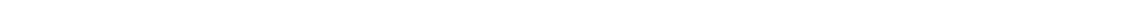
Fig. 1 Selective killing effects of a131 in cancer cells. a Structure of a131. b Normal and transformed BJ cells were treated with a131, paclitaxel or nocodazole at a range of different concentrations for 72 h in triplicate and cell viability was determined by MTT assay in comparison with indicated antiproliferative agents, hence a reduction in cell viability would imply cell cycle arrest and cell death. Mean values with ± standard deviation (S.D.) are shown ( n = 3). c , d Normal and transformed BJ cells were treated with a131 at 2.5 μ M for 48 h. c FACS analysis using BrdU and PI double staining of the indicated cells. Percentages of BrdU-positive (S) population indicating cell cycle arrest and subG1 ( < 2N) population indicating cell death are shown. Representative FACS analysis shown ( n = 3). d Immunoblot analysis of cleaved PARP and caspase-3 (Cas-3) indicating a131-induced apoptosis in transformed BJ cells (lanes 5, 6), but not normal counterparts (lanes 2, 3). Representative immunoblots shown ( n = 3). e MTT assay of human normal and cancer cell lines treated with a131 for 72 h ( n = 3). Mean concentration values for a131 to achieve 50% growth inhibition (GI 50 ) in each cell line are plotted with ± S.D. f FACS analysis of a series of engineered BJ-derived fi broblasts treated with a131 at 5 µ M for 48 h. Mean values of subG1 ( < 2N) population ± S.D. are shown ( n > 3). g , h Normal and transformed BJ cells stably expressing GFP-histone H2B were treated with a131 at 2.5 μ M for 32 h prior to fi xation. g Immuno fl uorescence analysis with representative images ( n = 3). h Quanti fi cation of cells ( n > 100 per condition) with the indicated centrosome numbers. Mean values ± S.D. are shown ( n = 3). i Mice bearing established tumor xenografts were treated orally (PO) or intraperitoneally (IP) twice daily with the indicated doses of a131 or its derivative b5. Tumor volumes were calculated periodically as indicated. Paclitaxel (PTX) was administered intravenously for twice every 4 days. Mean tumor volumes ± S.D. from six mice are shown. Two-way ANOVA was performed to determine statistical signi fi cance compared to vehicle control. j , k TUNEL staining ( j ) or immunohistochemical analysis ( k ) of HCT-15 tumor sections on Day 12 with representative images (top). j The percentage of TUNEL-positive cells were calculated from tumor sections. Note that detection of apoptosis by TUNEL and scanning of the entire sections of each slides, which contained both tumors and adjacent normal tissues, was performed in a completely unbiased manner. Moreover, for unbiased quanti fi cation, we used fi ve images from each sections of > 6 sections from each group (bottom). k Mean values of cell populations ( n > 100 per condition) with multipolar mitotic-spindles ± S.D. are shown (bottom) with representative images (top). White bars, 5 μ m. Where indicated, two-tailed unpaired t tests